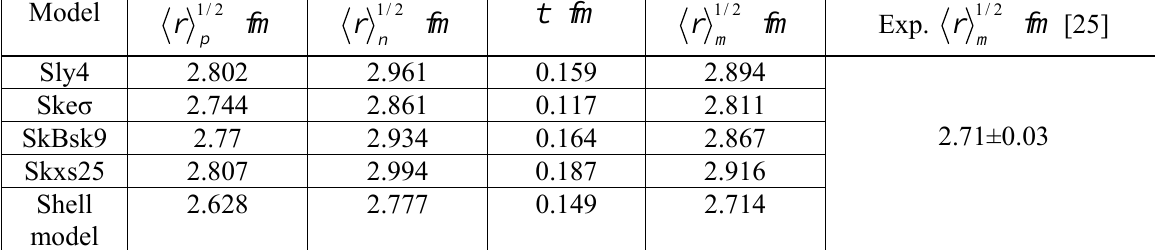
Table 1: The values of rms radii in fm of 21 F nucleus.